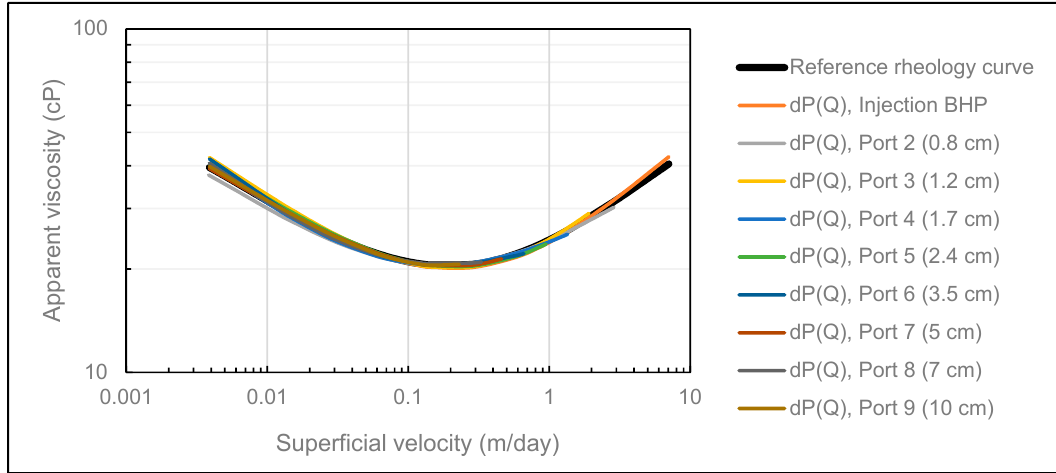
Figure 4. Comparison of the reference rheology curve (black) and rheology curves obtained in CMOST when the reference dataset was history matched using the SPMM.